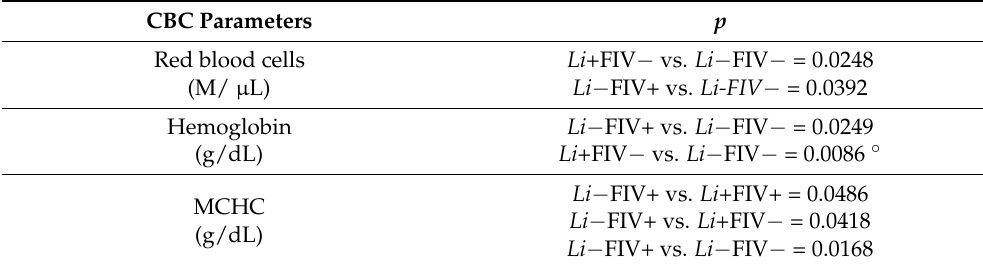
Table 5. p -values for the significant differences concerning CBC values.